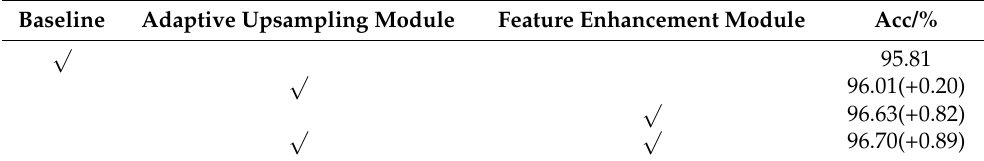
Table 4. Ablation experiment